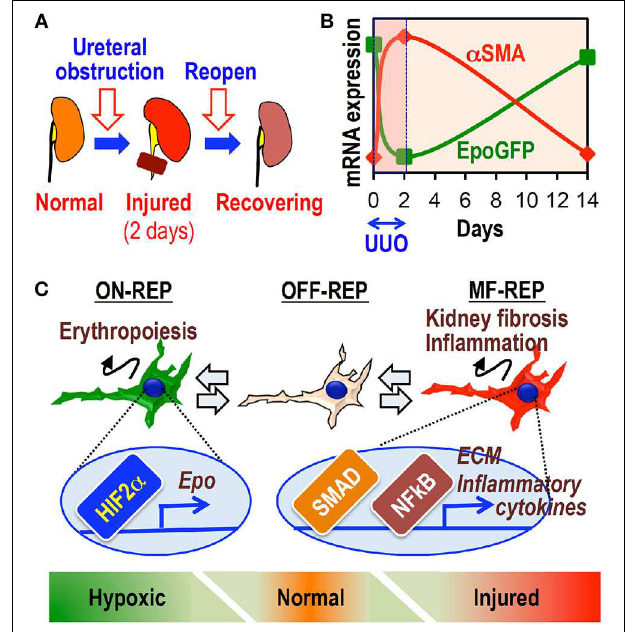
FIGURE 4 | Myofibroblast transformation of REPs. Immunohistochemical detection of myofibroblasts with α SMA antibody (red) in ureteral obstructed kidney of ISAM. EpoGFP-positive REPs (green) transform into myofibroblasts (MF-REPs) upon kidney injury induced by ureteral obstruction for 3 days. Blue: DAPI for nuclear staining. EpoGFP protein expression does not reflect ongoing Epo gene transcription due to its longer half-life. EpoGFP mRNA expression is immediately silenced by urinary obstruction ( Souma et al., 2013). Scale bar, 100 µ m.